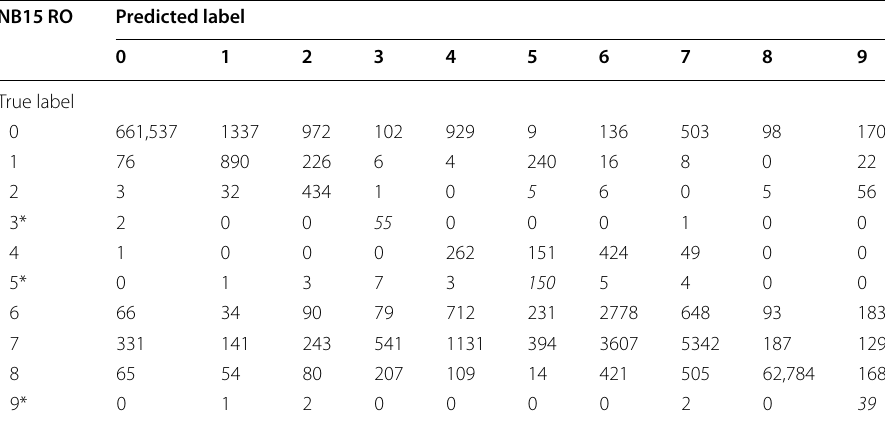
Table 24 Confusion Matrix: NB15 RO